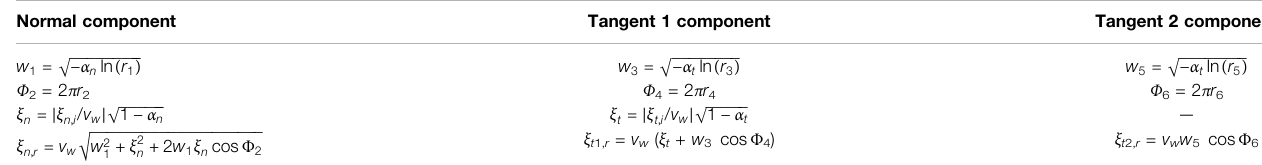
TABLE 2 | CLL algorithm for gas – surface re fl ection of rare fi ed hypersonic fl ows, reproduced from the study mentioned in reference [28]. Normal component Tangent 1 component Tangent 2